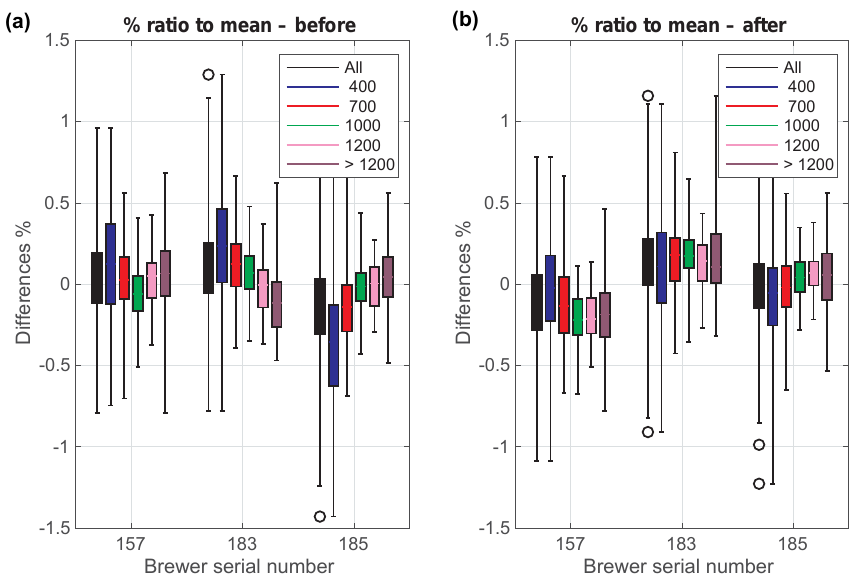
Figure 8. Box plot of the ozone percentage deviation from the mean of the RBCC-E triad reference Brewer no. 157, Brewer no. 183 and Brewer no. 185 before (a) and after (b) the X RBCC-E campaign at El Arenosillo in 2015, grouped by ozone slant column ranges. The colour indicates the intervals used for the averaging of the observations – blue, lower than 400DU; red, between 400 and 700DU; green, between 700 and 1000DU; pink, between 1000 and 1200DU; and purple for OSC > 1200DU. In black is shown the average of all observations.